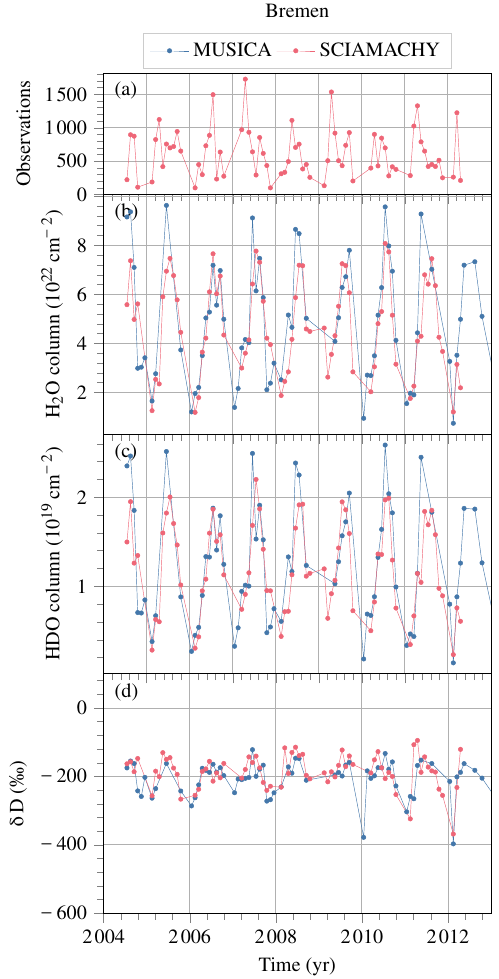
Figure 3. Time series of monthly medians of H 2 O (b) , HDO (c) and δ D (d) for the MUSICA ground station Bremen (blue) and col- located SCIAMACHY observations for clear-sky conditions (red). Panel (a) shows the number of SCIAMACHY measurements in each month.